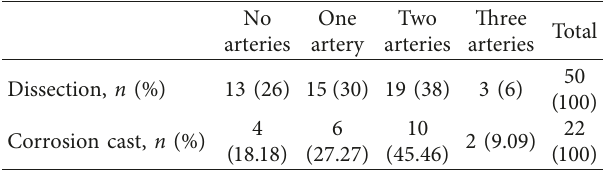
Table 3: Number of arteries that vascularize the tail of the pancreas.